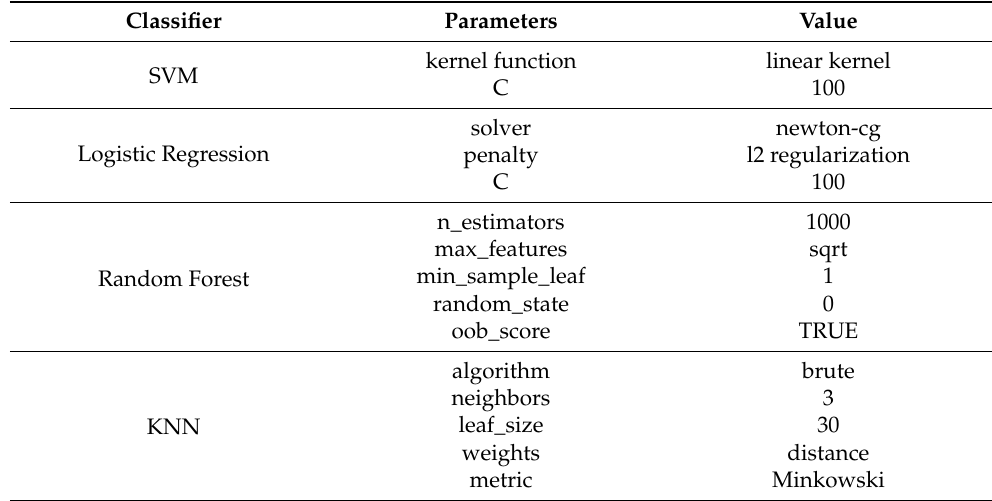
Table 5. Hyperparameter tuning for each